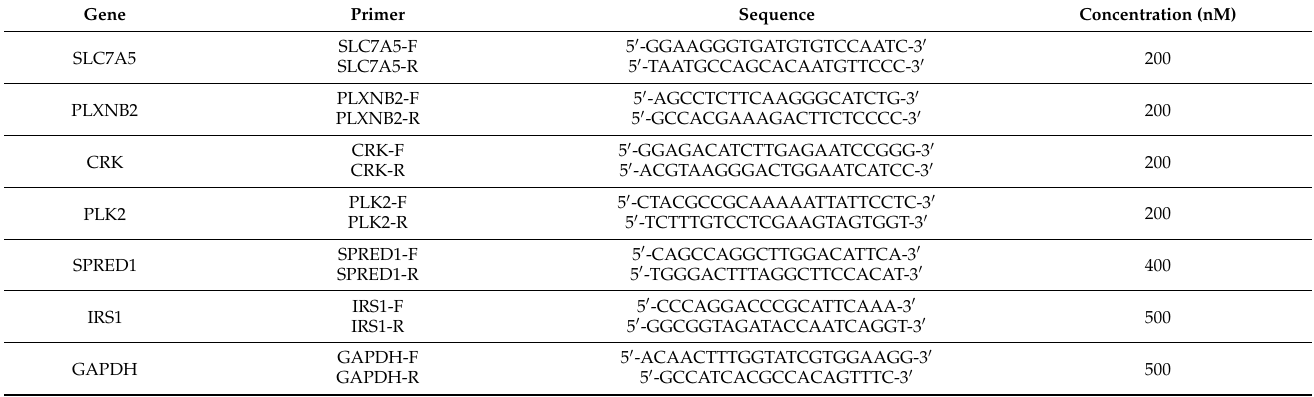
Table 2. Sequences and Concentrations of Primers of GAPDH and miR-126 Predicted Targets Extracted from